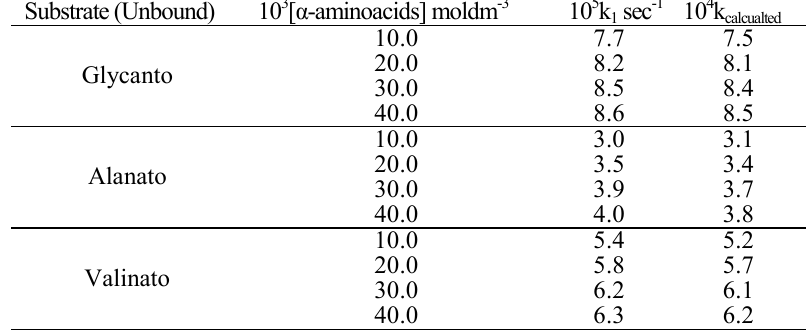
Table 4 . First order rate constants for Mn(III)acetate of Co(III) complexes of α-amino acids in CTAB at 28±0.2 o C. The formation constants for Mn(III)acetate of Co(III)complexes of α- amino acids in CTAB along with the limiting specific rates. Mn(III)=1 M, H CTAB=0.01 M, Temp 28± 0.2 o